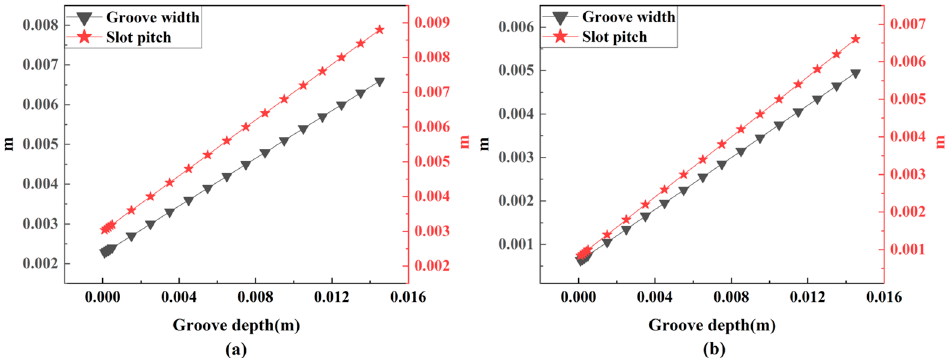
Figure 8. Groove width and slot pitch change under different groove depths: ( a ) inlet section of the BSCN and ( b ) outlet section of the BSCN.